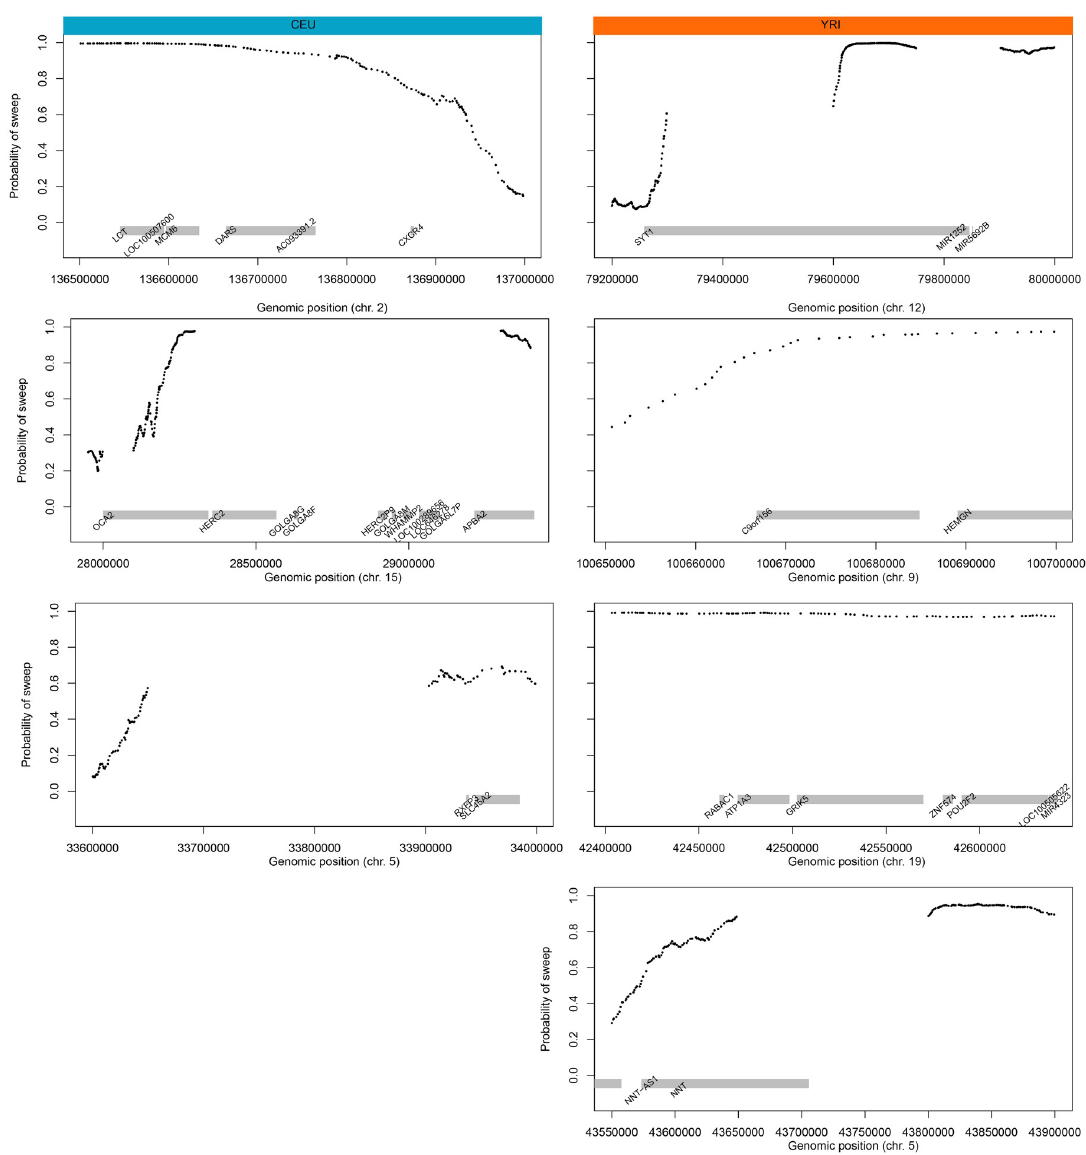
Fig 8. SURFDAWave classifier’s application to empirical data for CEU (left column) and YRI (right column) populations. Probability of sweep across the genomic region of labeled chromosome containing the genes of interest. SURFDAWave is trained to differentiate between selective sweeps and neutrality with simulations conducted under demographic specifications of the CEU or YRI demographic history. The black dots show the predicted probability of sweep and the gray bars show the positions of the labeled genes. Gaps between black dots are the result of filtering low quality genomic regions (see Application of empirical data ), such that no SNPs exist in these regions and can therefore not be classified (see S33 Fig as an example of how we classify a SNP spanned by our feature